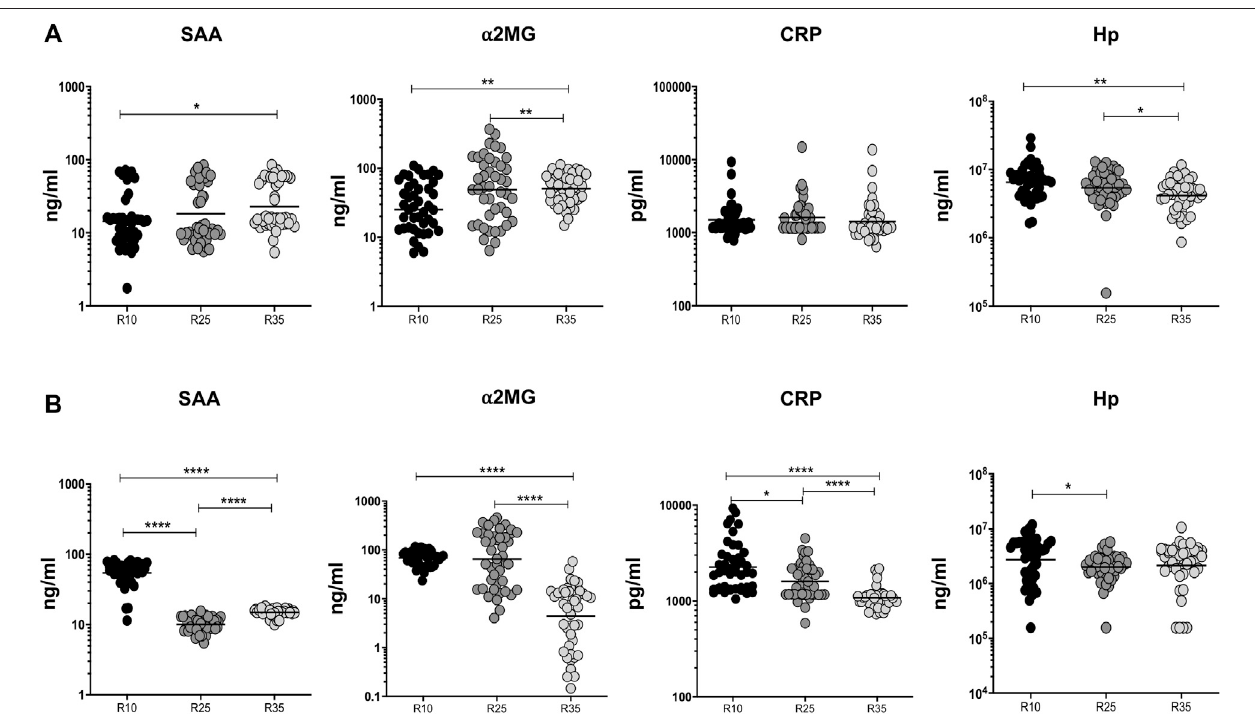
FIGURE 5 | High dose rifampicin is associated with reduced APPs at the second month in PTB individuals. (A) Baseline plasma levels of APPs (SAA, α 2MG, CRP, and Hp) between the three different rifampicin (R10 [ n = 44], R25 [ n = 44], R35 [ n = 44]) treated arm of PTB individuals. (B) Second month plasma levels of APPs (SAA, α 2MG, CRP, and Hp) between the three different rifampicin (R10 [ n = 44], R25 [ n = 44], R35 [ n = 44]) treated arm of PTB individuals. We used Kruskal – Wallis test with Dunn ’ s multiple comparisons to measure the p values and each individual were denoted using scatter